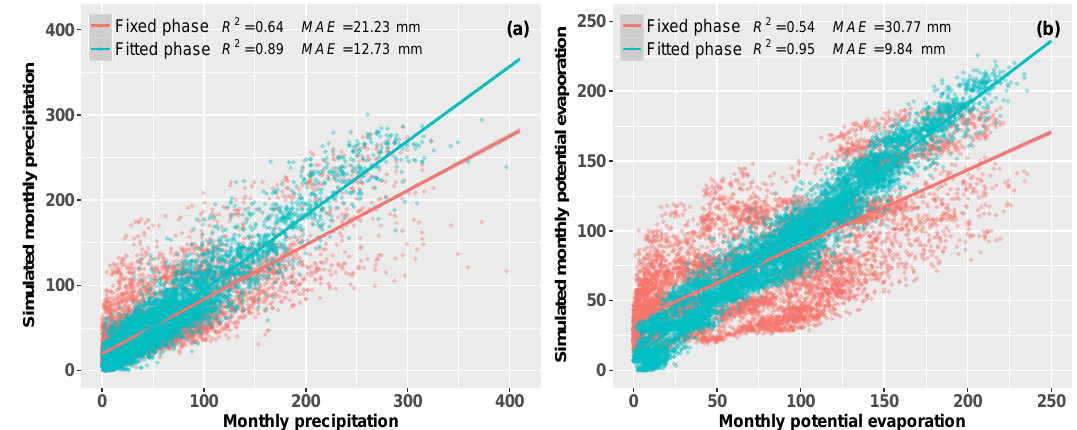
Figure 2. Comparing the observed and simulated monthly precipitation and potential evapotranspiration, using the sine function with a fixed phase (i.e., Eq. 4) and fitted phase (i.e., Eq. 6). Note that each point represents 1-month data based on the combined dataset from 26 global large